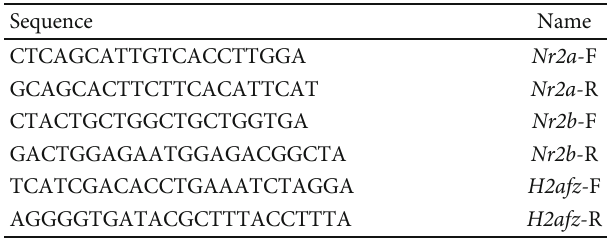
Table 1: Sequences of primers.